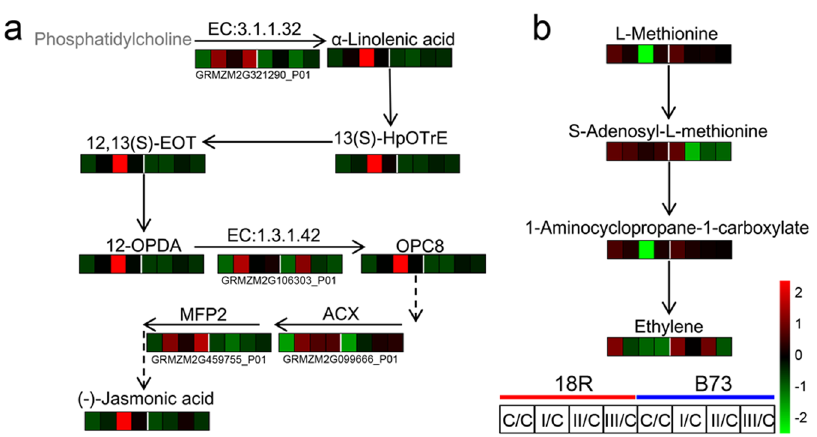
Figure 6. Effects of medium induction on the proteins and metabolites of the jasmonic acid ( a ) and ethylene ( b ) synthesis pathways. The heatmap represents the metabolite and DEP abundance at different stages of 18R and B73. The gray metabolite was not detected or did not significantly